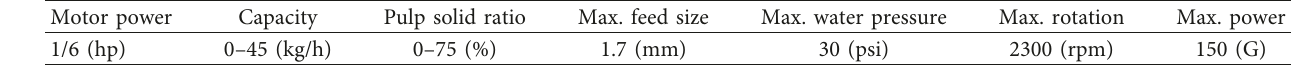
Table 9: Technical specifications of KC-MD3 model laboratory-type Knelson concentrator.